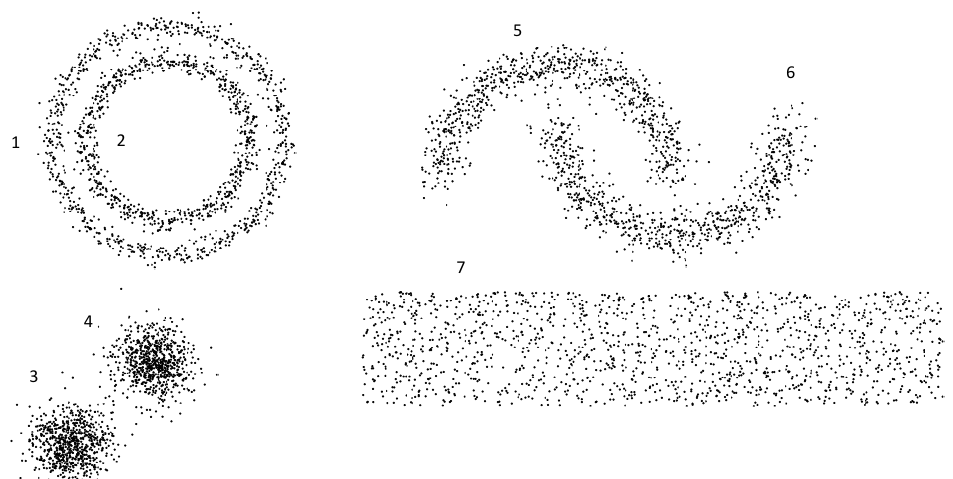
Figure 2. Network model within the boundaries of an intersection based on two-dimensional normal and uniform distributions .